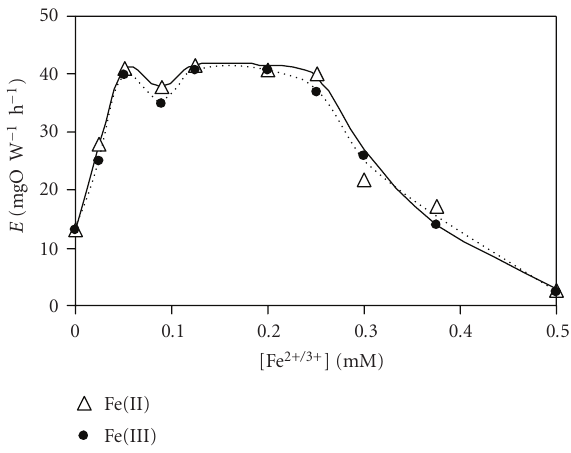
Figure 1: The e ffi ciency of PCO of ethylene glycol (EG) in TiO 2 suspension versus concentration of Fe 2+ ( Δ ) and Fe 3+ ( • ) ions at pH 3.